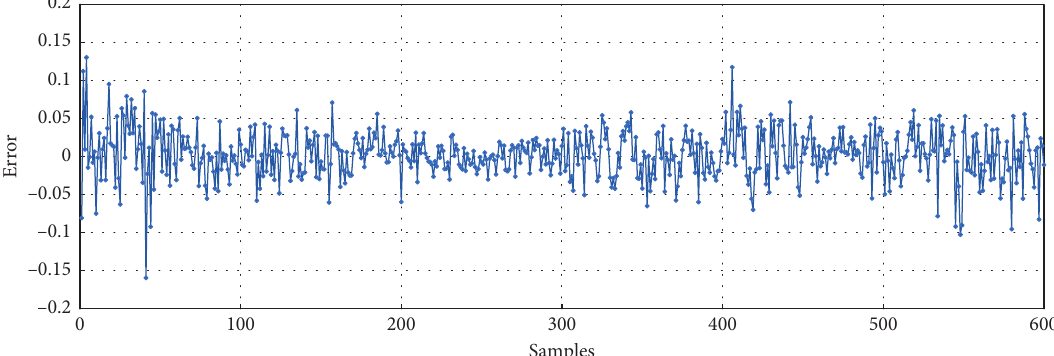
Figure 6: Prediction error of INNMF.